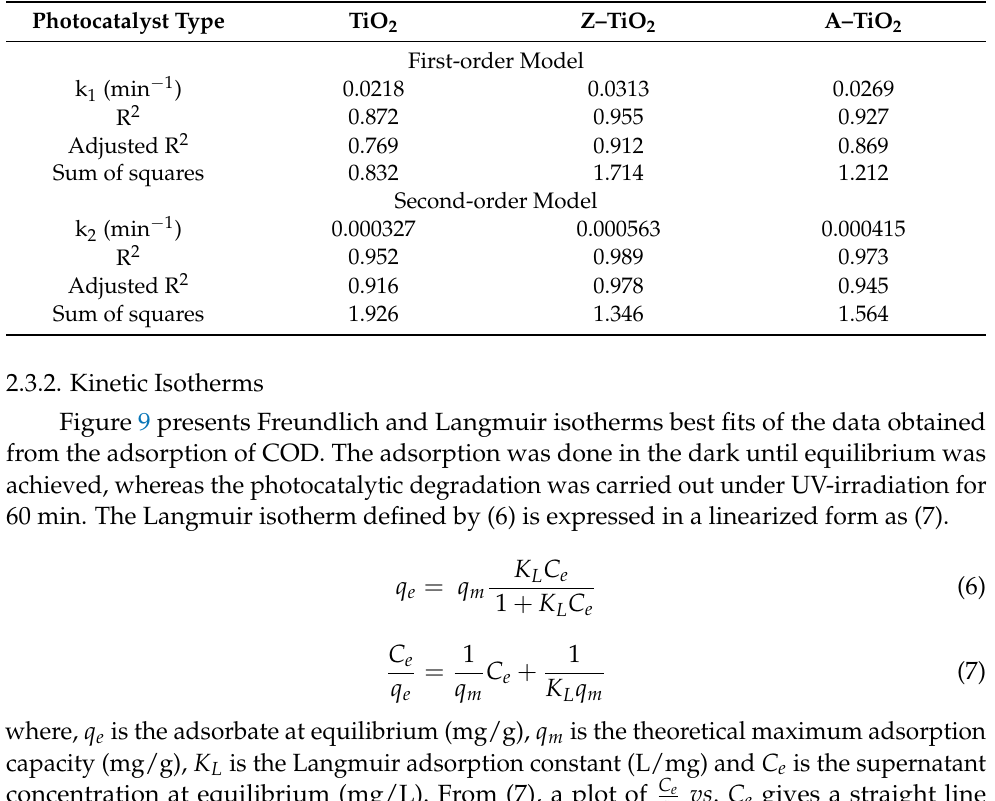
Table 2. Kinetics data for the removal of COD with a catalyst load of 4 g.